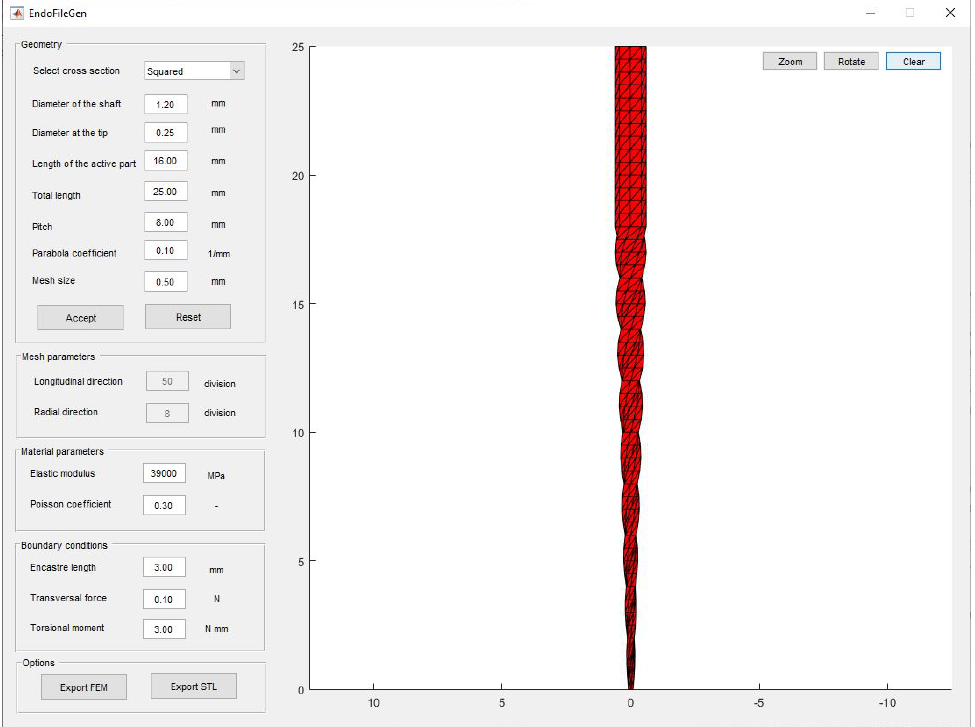
Figure 5. Graphical interface for the developed computer